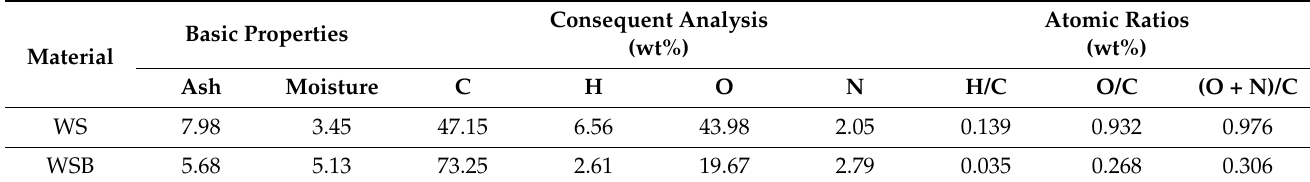
Table 1. Elemental composition of WS and WSB.